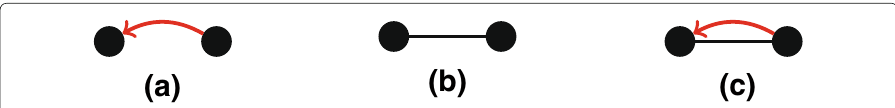
Fig. 1 Link types in the multiplex corporate network. a Ownership link, b Board interlock link, c Multiplex